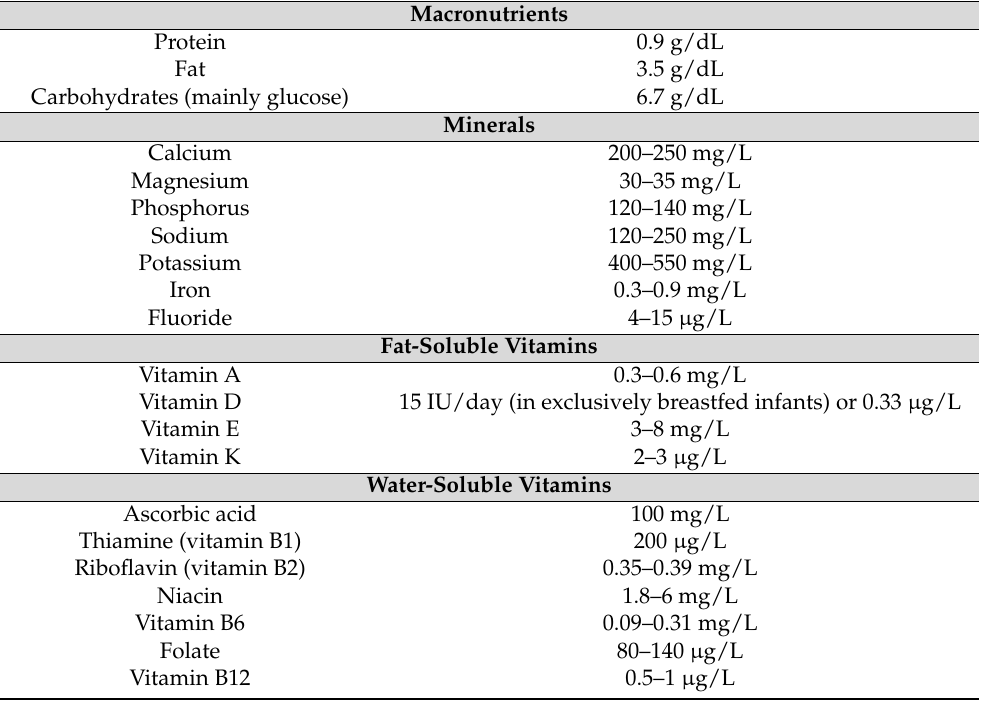
Table 1. Main nutrient constituents of human milk and respective concentrations